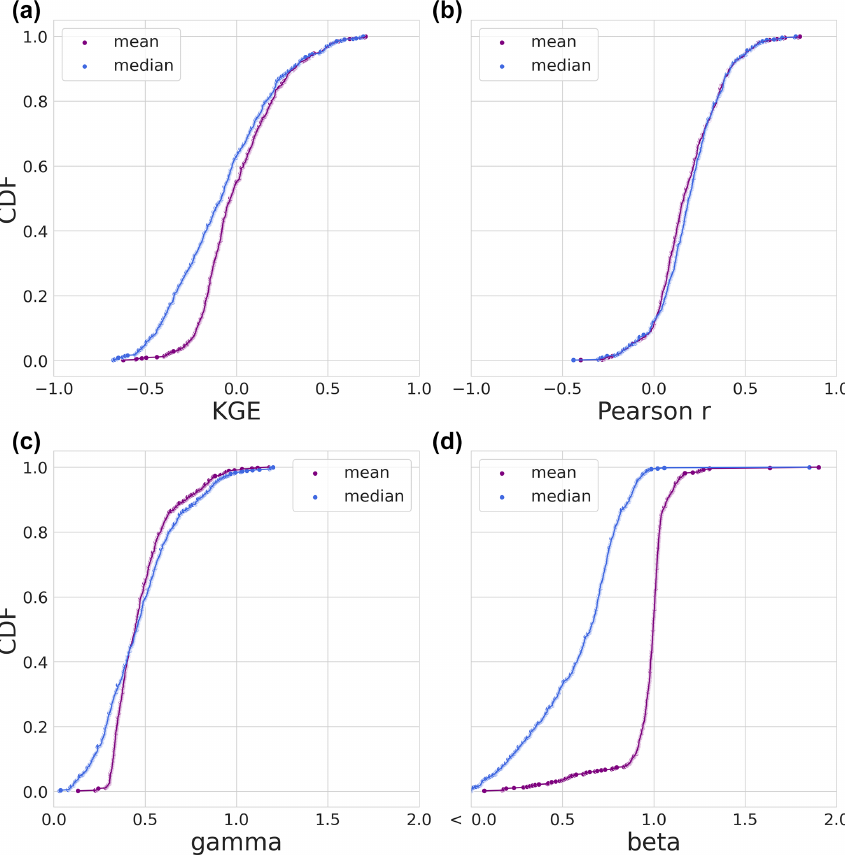
Figure 6. Evaluation period results. The CDFs of the modified KGE score and its three individual components of the statistical benchmark during the evaluation period. The mean is shown in purple and the median statistical benchmark in blue. (a) The CDF of the modified KGE score. (b) The CDF of the Pearson r correlation KGE component. (c) The CDF of the gamma (variability ratio) KGE component. (d) The CDF of the beta (bias ratio) KGE